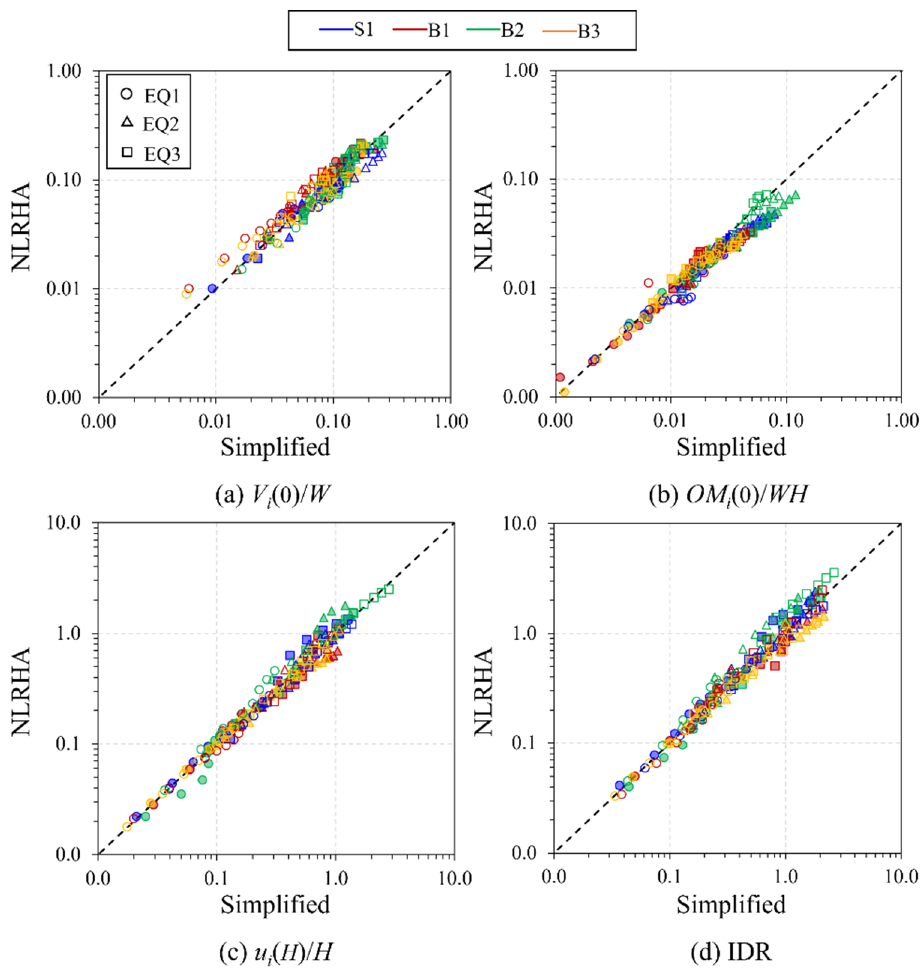
Figure 19. Comparison between various responses of the simplified and NLRHA procedures for all case study buildings excited by the eight levels of EQ1, EQ2, and EQ3.